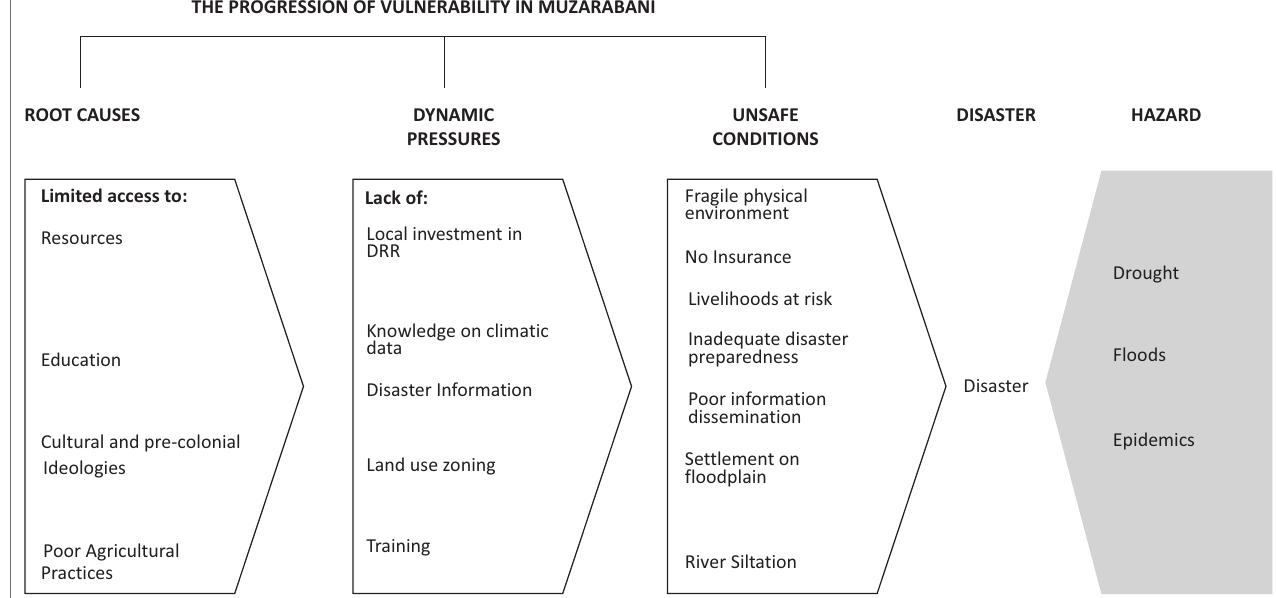
FIGURE 6: Pressure and release model depicting the progression of vulnerability in